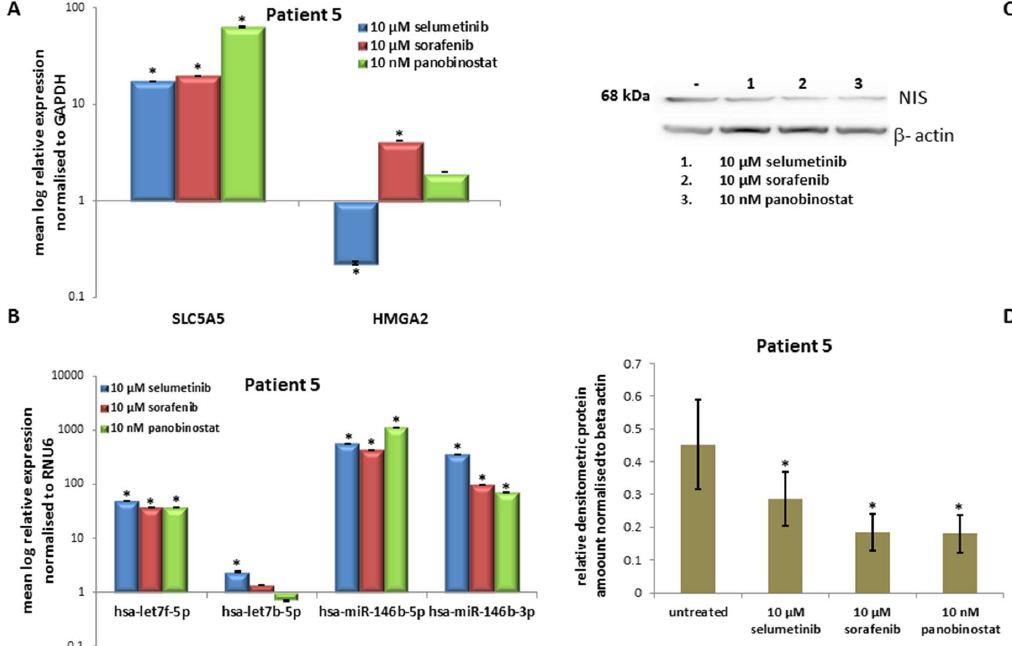
Figure 10. Effects of selumetinib, sorafenib and panobinostat on mRNAs, miRNAs and NIS protein expression in PDTT of patient 5 (PDTC). RT-qPCR of NIS , HMGA2 ( A ), hsa-let7f-5p, hsa-let7b-5p, hsa-miR-146b-5p and hsa-miR-146b-3p ( B ). The expression was normalized to GAPDH ( A ) and